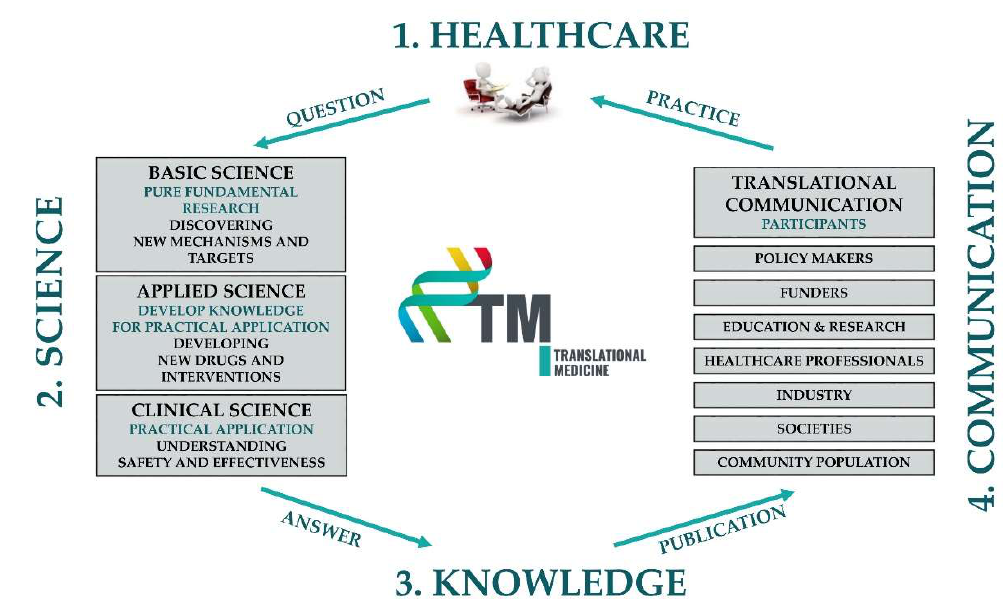
Figure 2. The translational medicine (TM) cycle.